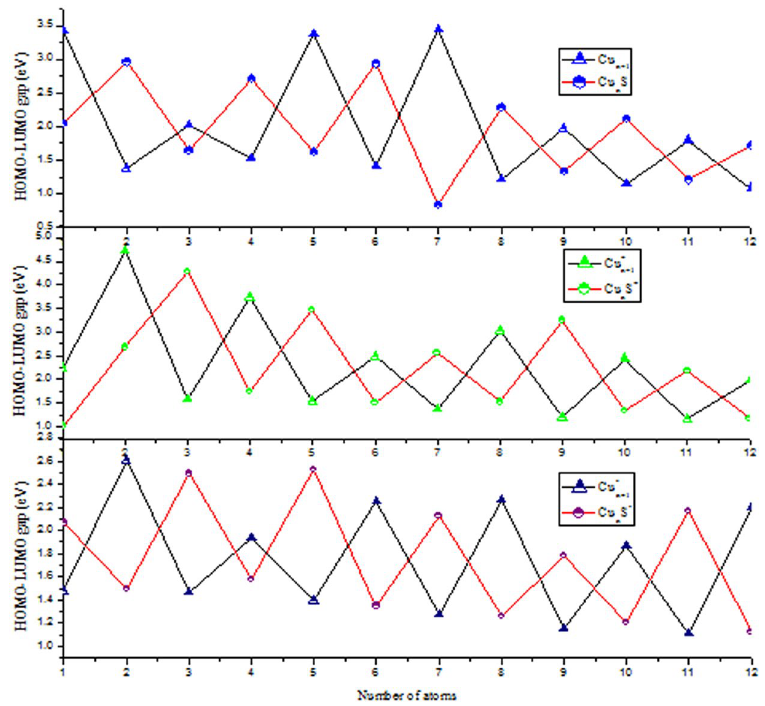
Figure 3. The HOMO-LUMO energy gaps for the lowest energy structures of neutral and charged Cu n + 1 and Cu n S (n = 1–12)